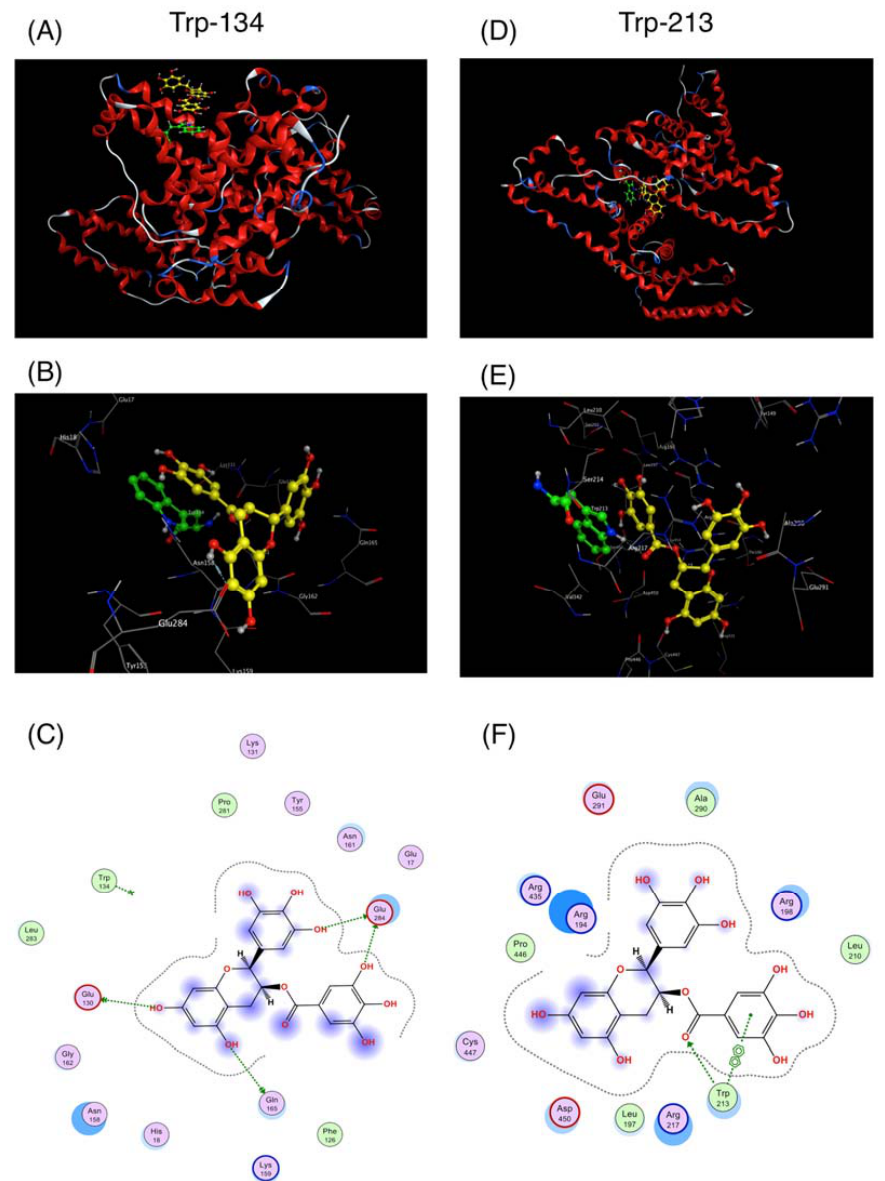
Figure 1. Interaction of epigallocatechin gallate (EGCg) with Trp residues in bovine serum albumin (BSA) by docking simulation. The simulation was carried out using the Docking program of the Molecular Operating Environment (MOE) suite. 3D model of the docking pose of EGCg (yellow) against Trp-134 at the protein surface ( A ) and against Trp-213 in the drug-binding site I ( D ) of BSA (red cartoon). Enlarged views of (A) and (D) are shown in ( B ) and ( E ), respectively. 2D models of (B) and (E) are shown in ( C ) and ( F ), respectively.